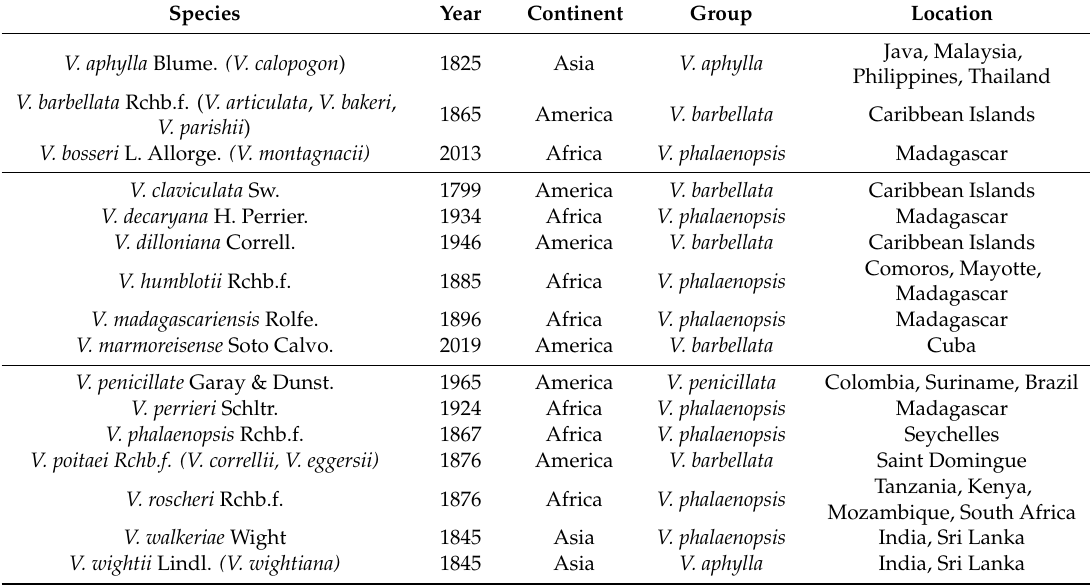
Table 1. List of the 16 leafless Vanilla species accepted by Govaerts et al. [27]. Synonyms are in